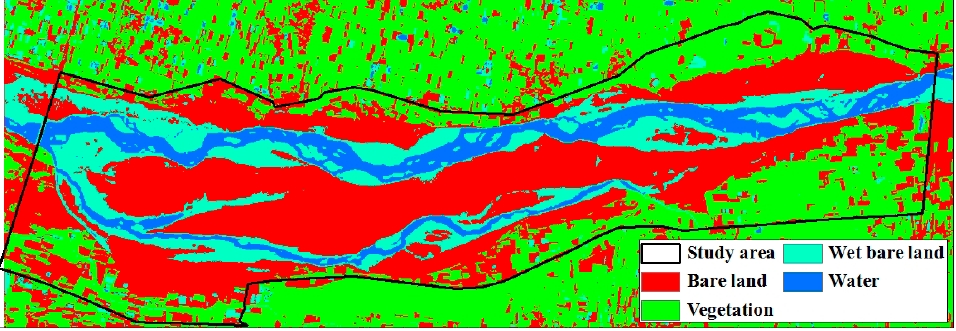
Figure 6. Result of land cover classification.